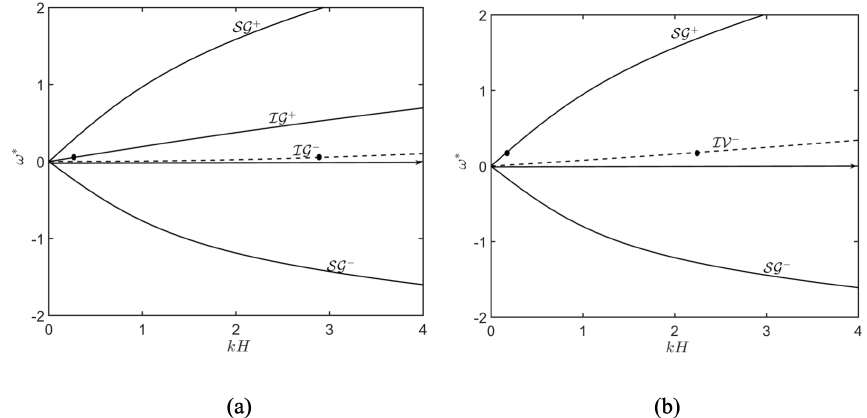
= U ∗ = 0 . 1, h u /h = 1 / 3, l l b = 0 . 1, U ∗ = 0, h u /h = 1 / 3, and l √ l b gH , where H = h u + h l .